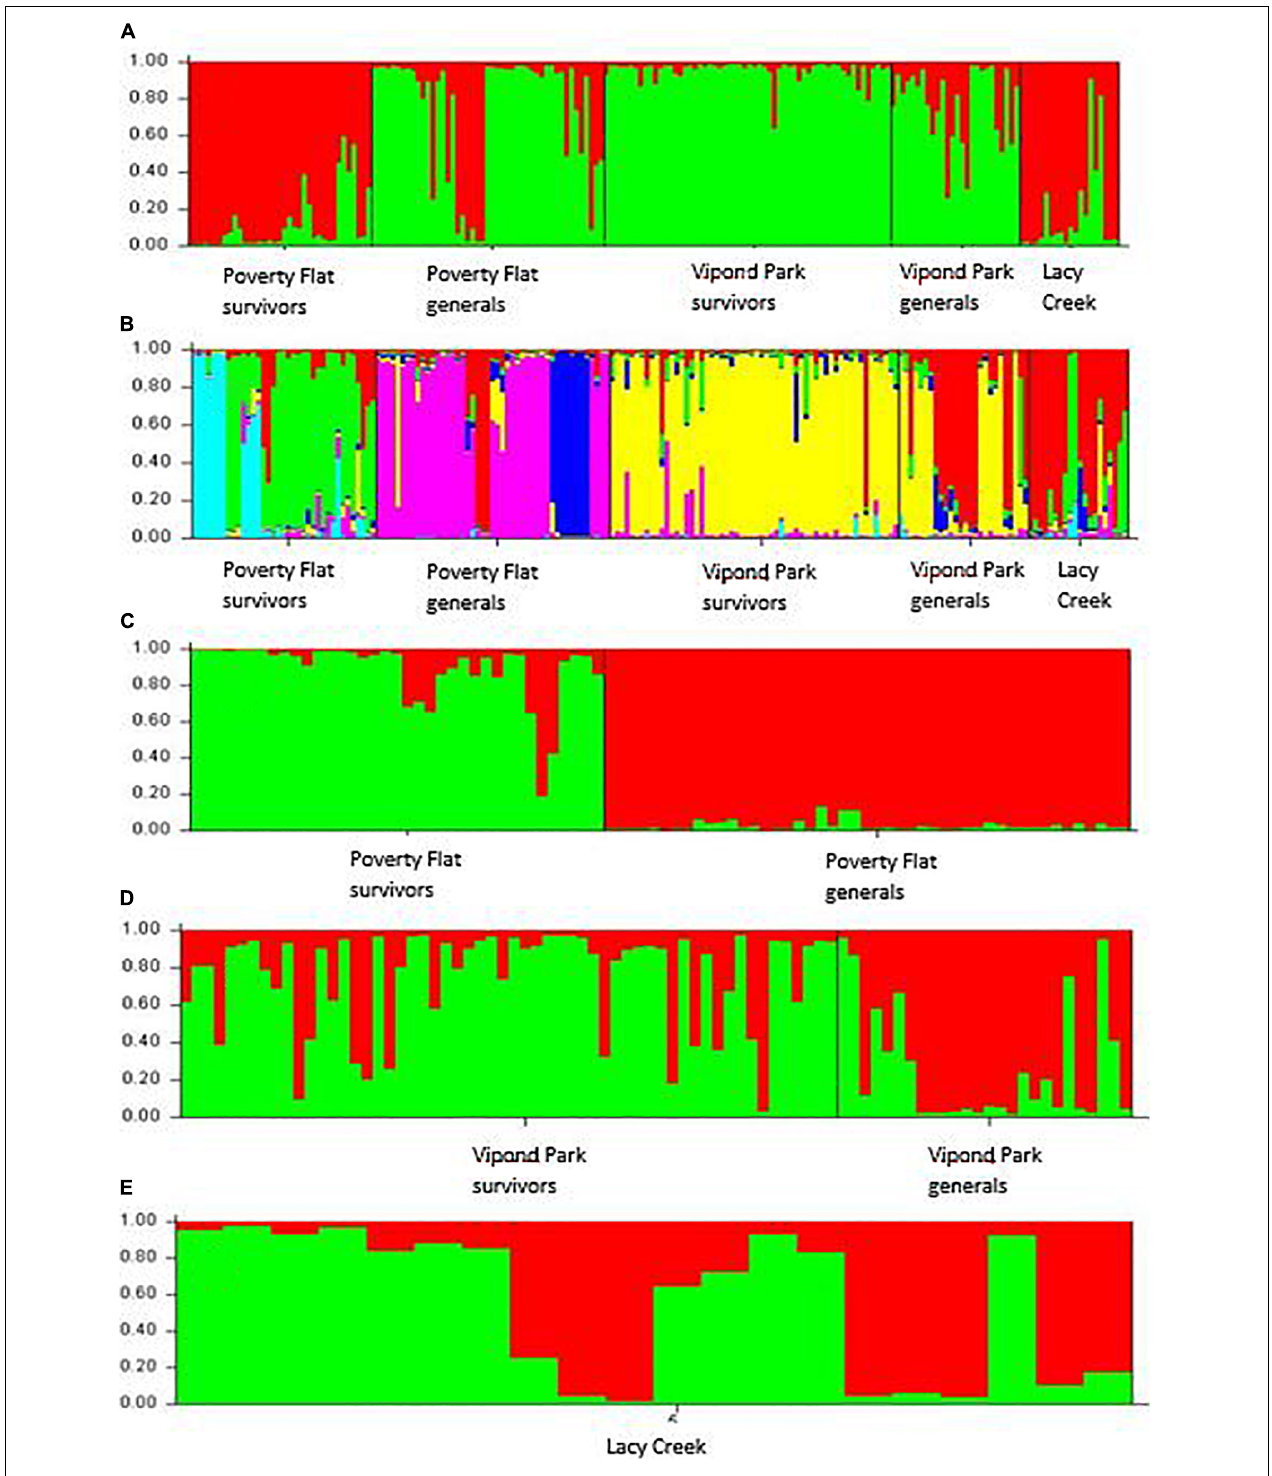
FIGURE 1 | STRUCTURE analysis of inter-simple sequence repeat data for Pinus albicaulis survivors and generals at Poverty Flat, ID, Vipond Park, MT (populations experiencing a Dendroctonus ponderosae outbreak) and living trees at Lacy Creek, MT (no outbreak) (specifics provided in text). (A) All sites and categories combined assuming K = 2 based on initial STRUCTURE analysis prior to analysis by site. (B) All sites and categories combined assuming K = 6 based on outcomes of individual site analyses. (C,D) Analysis by site supported K = 2 at each: (C) Poverty Flat, (D) Vipond Park, and (E) Lacy Creek.